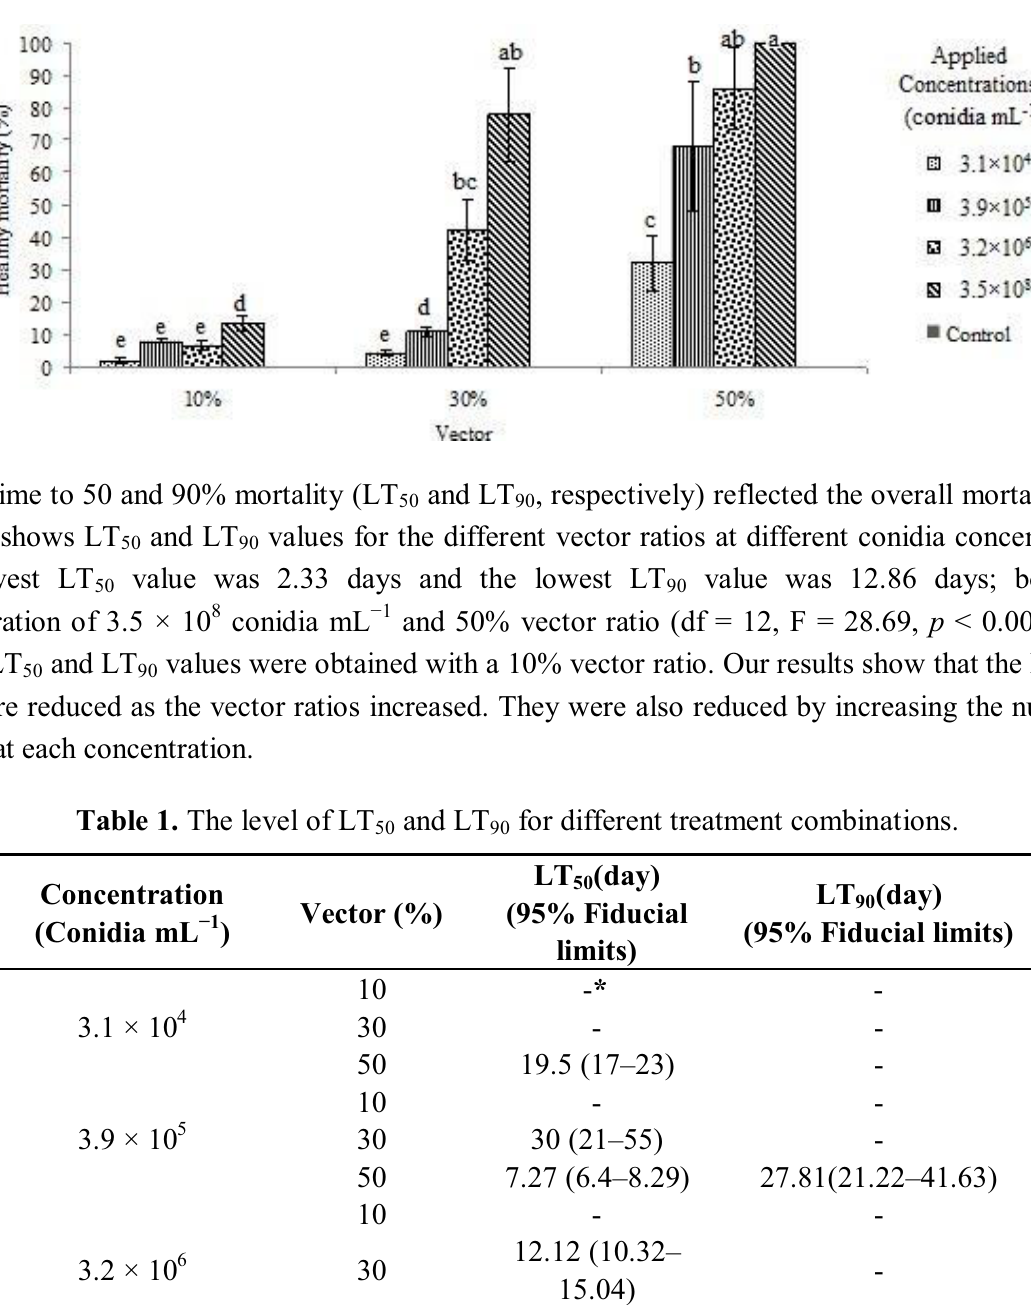
Figure 3. The level of healthy (recipient) workers mortality for different treatment combinations.